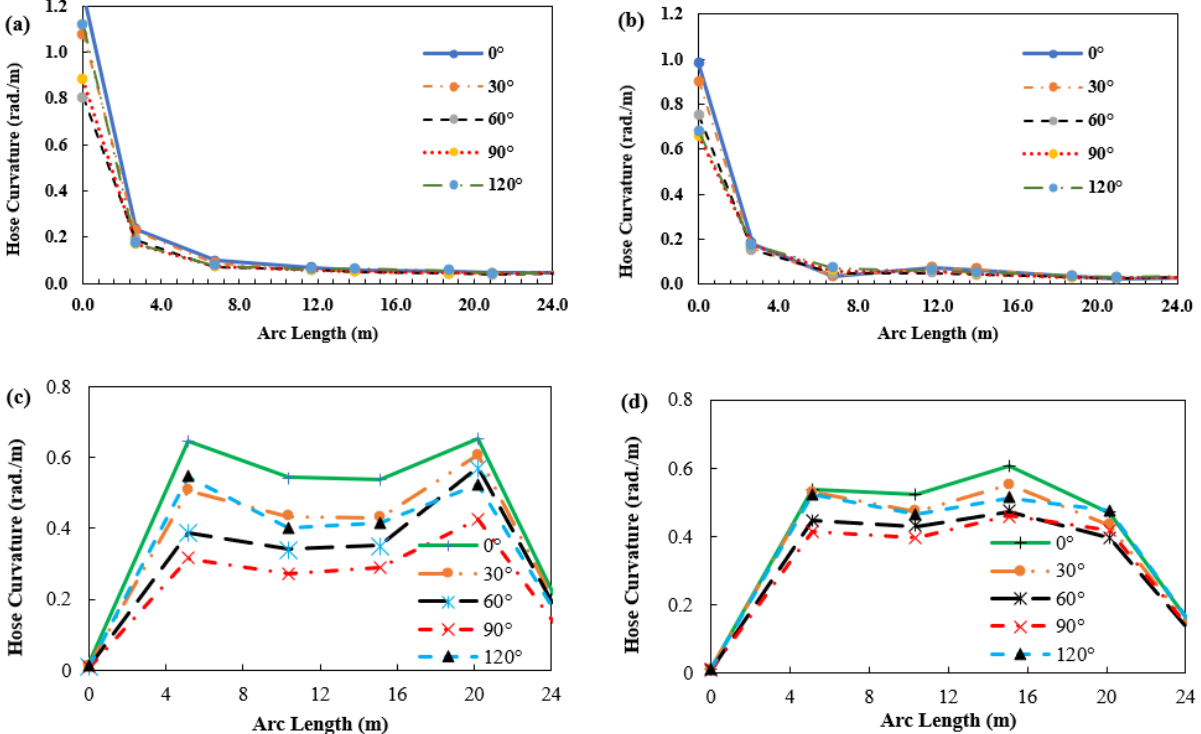
Figure 21. Influence of loadings from hydrodynamics on the curvature of the submarine hose. ( a ) Hose Curvature including hose hydrodynamic load in Lazy-S config. ( b ) Hose Curvature excluding hose hydrodynamic load in Lazy-S config. ( c ) Hose Curvature including hose hydrodynamic load in Chinese-lantern config. ( d ) Hose Curvature excluding hose hydrodynamic load in Chinese-lantern config.